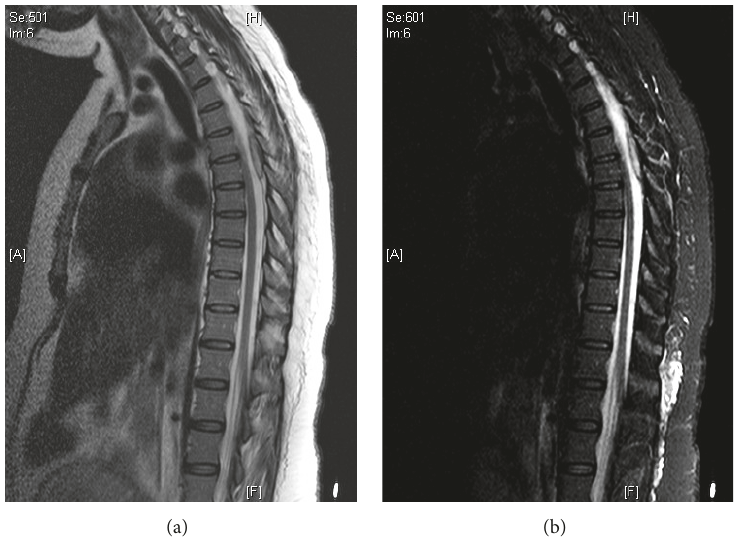
Figure 1: (a, b) MRI images at 14 hours postpartum showing a spinal epidural hematoma measuring 3.5cm x 0.4 cm. There is also spinal stenosis at T5-T6 due to extrinsic mass effect of the epidural hemorrhage.